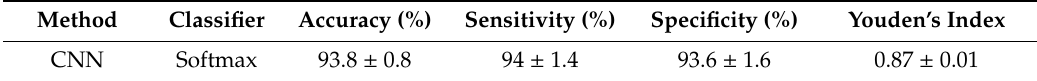
Table 1. Baseline CNN classification.